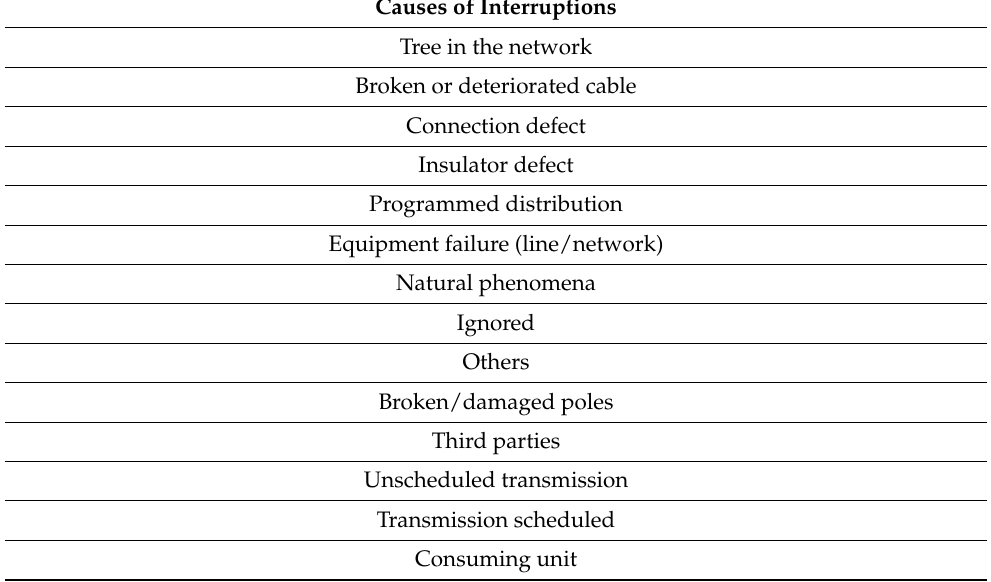
Table 1. Causes of